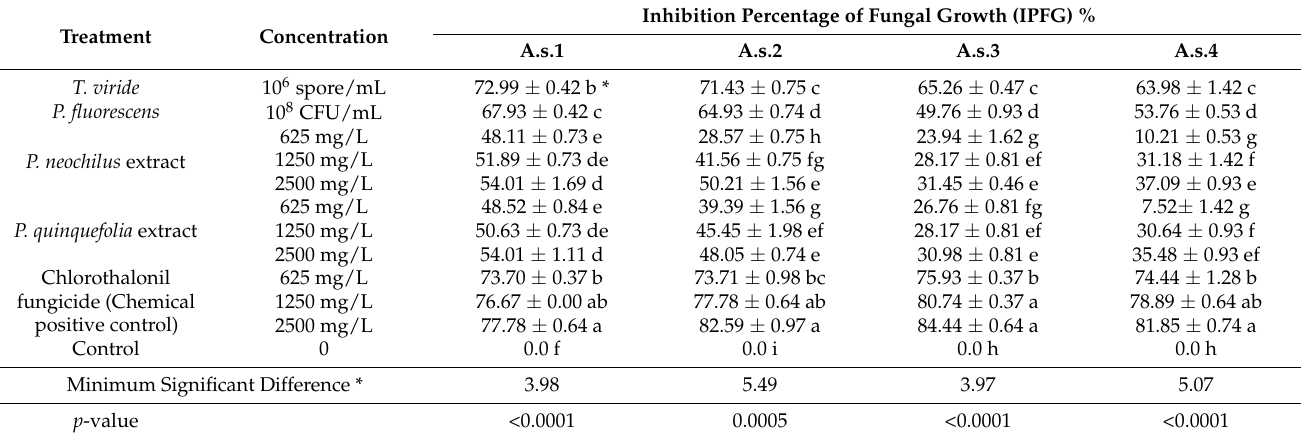
Table 3. Antifungal activity of T. viride and P. fluorescens bioagents, P. neochilus and P. quinquefolia plant extracts and Chlorothalonil fungicide (Brado72%SC ® ) on A. solani isolates under in vitro condition. Treatment